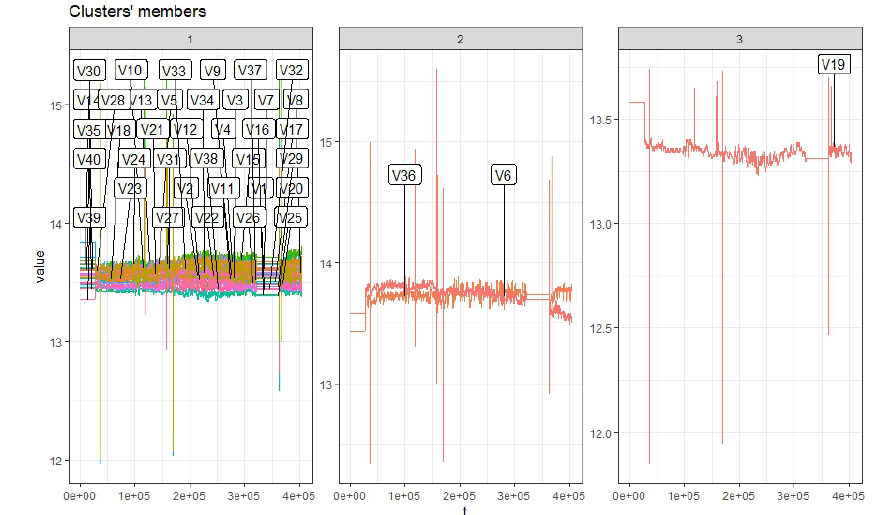
Figure 9. DTW clustering after nine